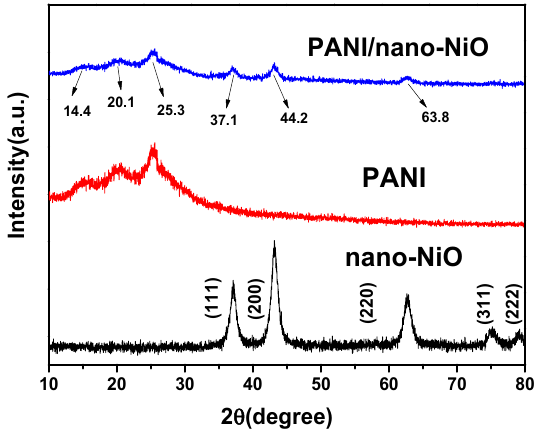
Figure 4. XRD spectra of nano-NiO, PANI, PANI/nano-NiO.